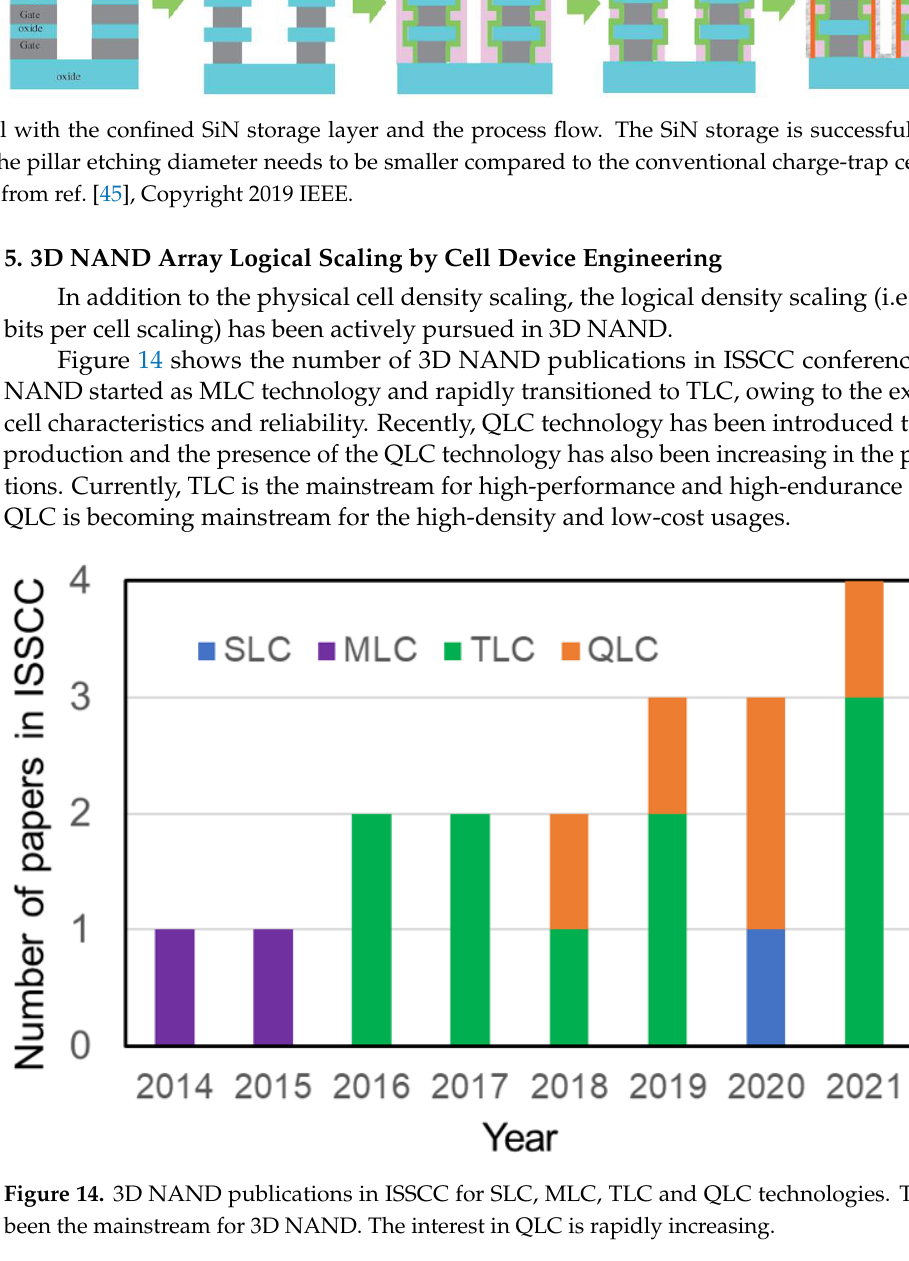
Figure 12. Split cells with ( a ) planar cell and ( b ) semicylindrical cell. Both of these achieve physical density scaling. The extra cell-to-cell interference needs to be managed to achieve good cell characteristics and high reliability. Reprinted with permission from refs. [41,43], Copyright 2015 and 2019 IEEE, respectively.